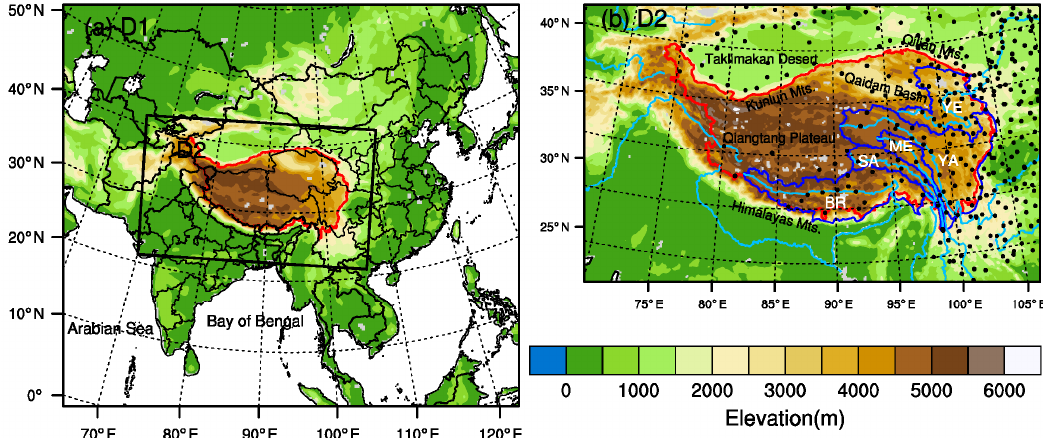
Figure 1. Domain configuration of the nested nonhydrostatic regional climate model RegCM (RegCM4) simulations with 30-km resolution ( a ) as well as 10-km resolution ( b ) and the study area including the Tibetan Plateau and the source region of five major river originated in the TP. Note that YE, YA, ME, SA, and BR represent the Yellow River, Yangtze River, Mekong River, Salween River, and Brahmaputra River. The meteorological stations applied for constructing the observational dataset are marked by black dots (modified from Gu et al. [35]).